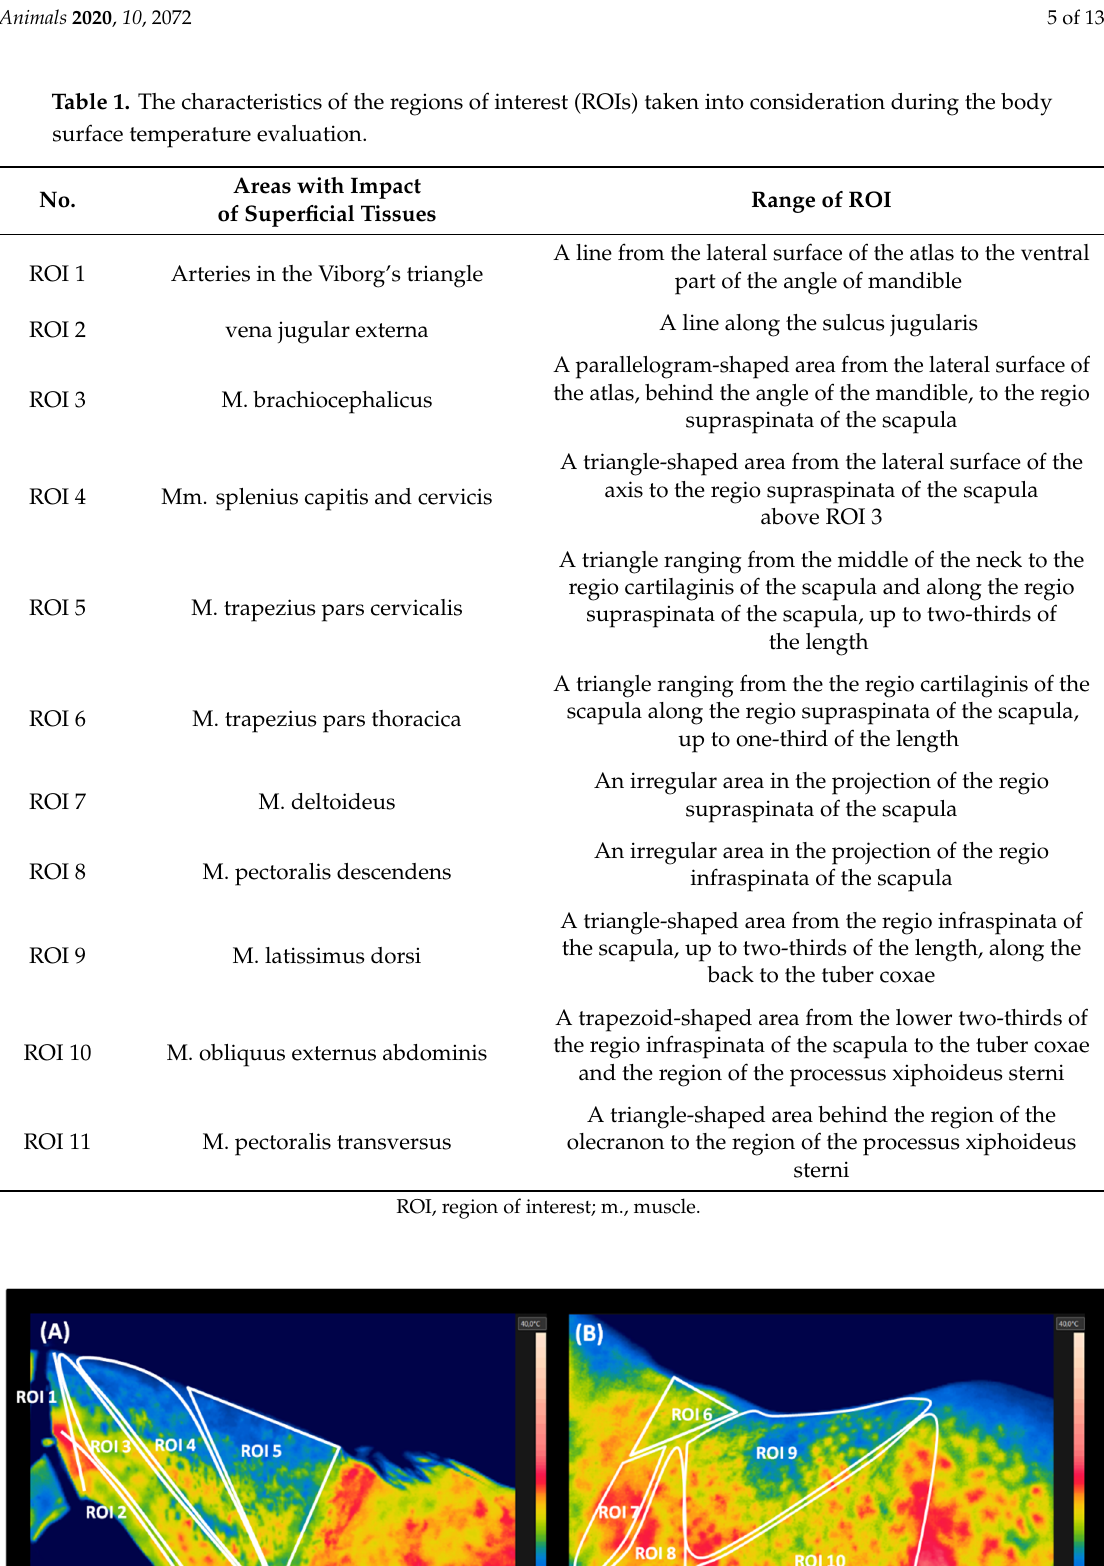
Table 1. The characteristics of the regions of interest (ROIs) taken into consideration during the body surface temperature evaluation.